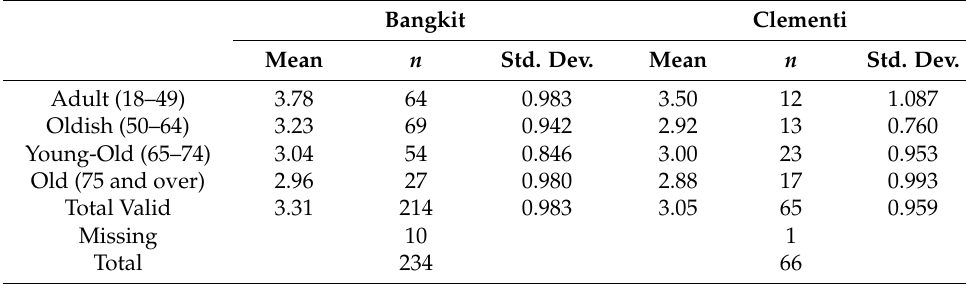
Table 6. Health condition scores across age